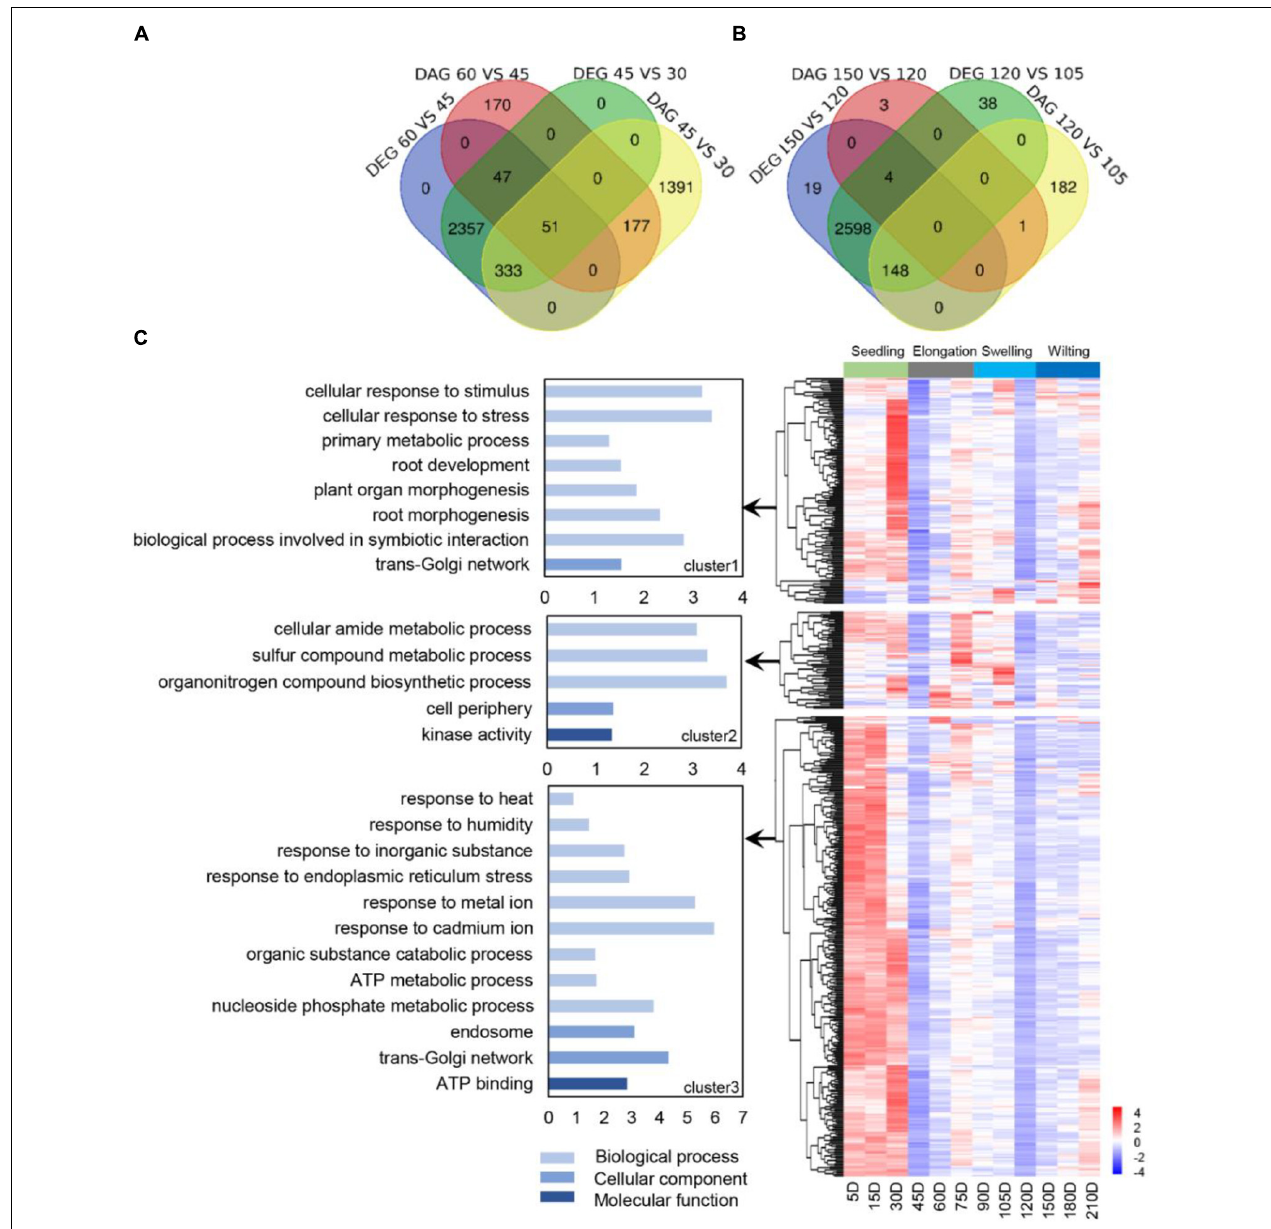
FIGURE 2 | Selection and annotation of active AS genes relevant to splicing switch. (A) The Venn diagram of differentially expressed genes (DEG) and differentially spliced genes (DAS) genes at developmental nodes before and after 45 DAG and 120 DAG (B) . (C) Hierarchical clustering and GO enrichment of 521 active AS. The active genes showed three co-expressed modules. The z-score scale represents the mean-subtracted regularized log-transformed FPKM. AS, alternative splicing; GO, gene oncology.